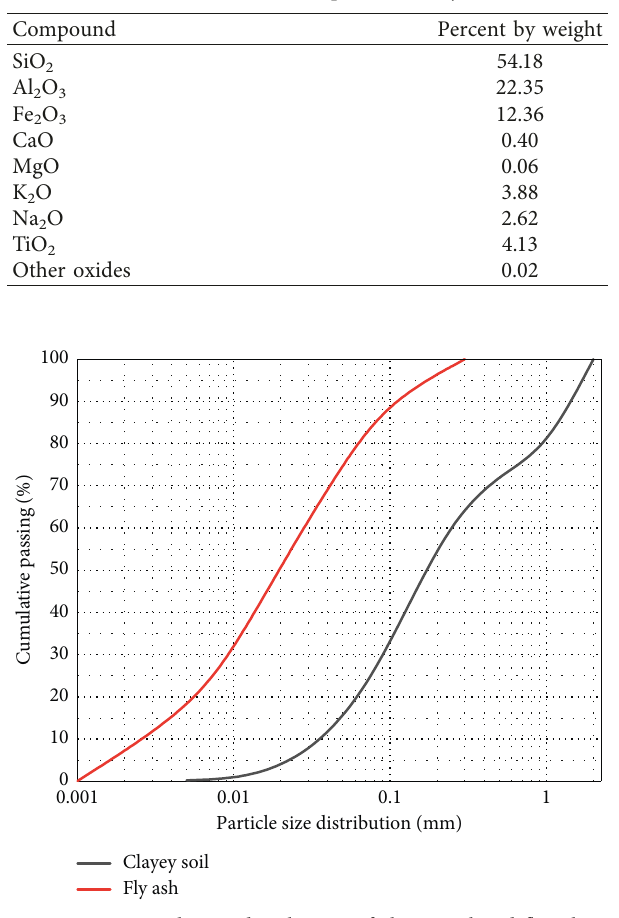
Table 2: Chemical composition of fly ash.